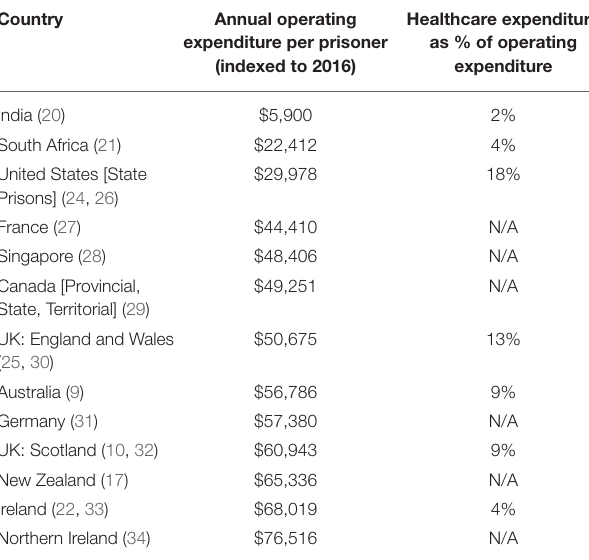
TABLE 4 | Annual overall prison operating costs and healthcare expenditure as percentage of operating